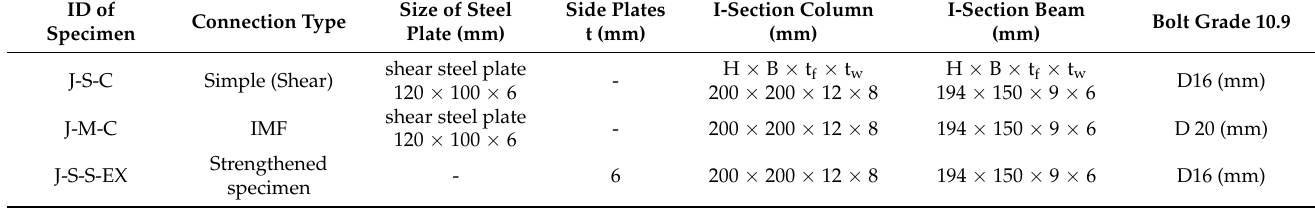
Table 1. Details of the tested steel frame specimens [29].